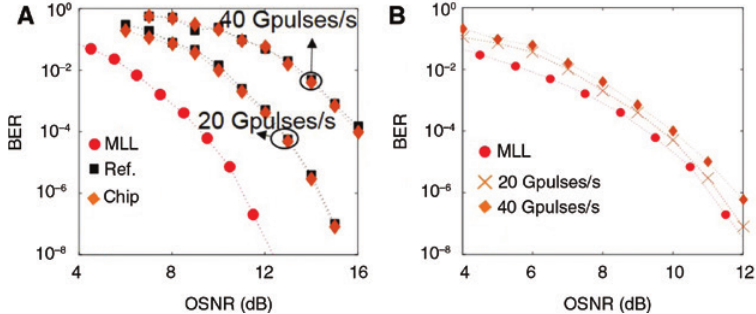
Figure 7: BER measurements: (A) received on-off keying signals for the commercial optical clock multiplier and chip; (B) optimal transmis- sion case for MLL and chip with different pulse